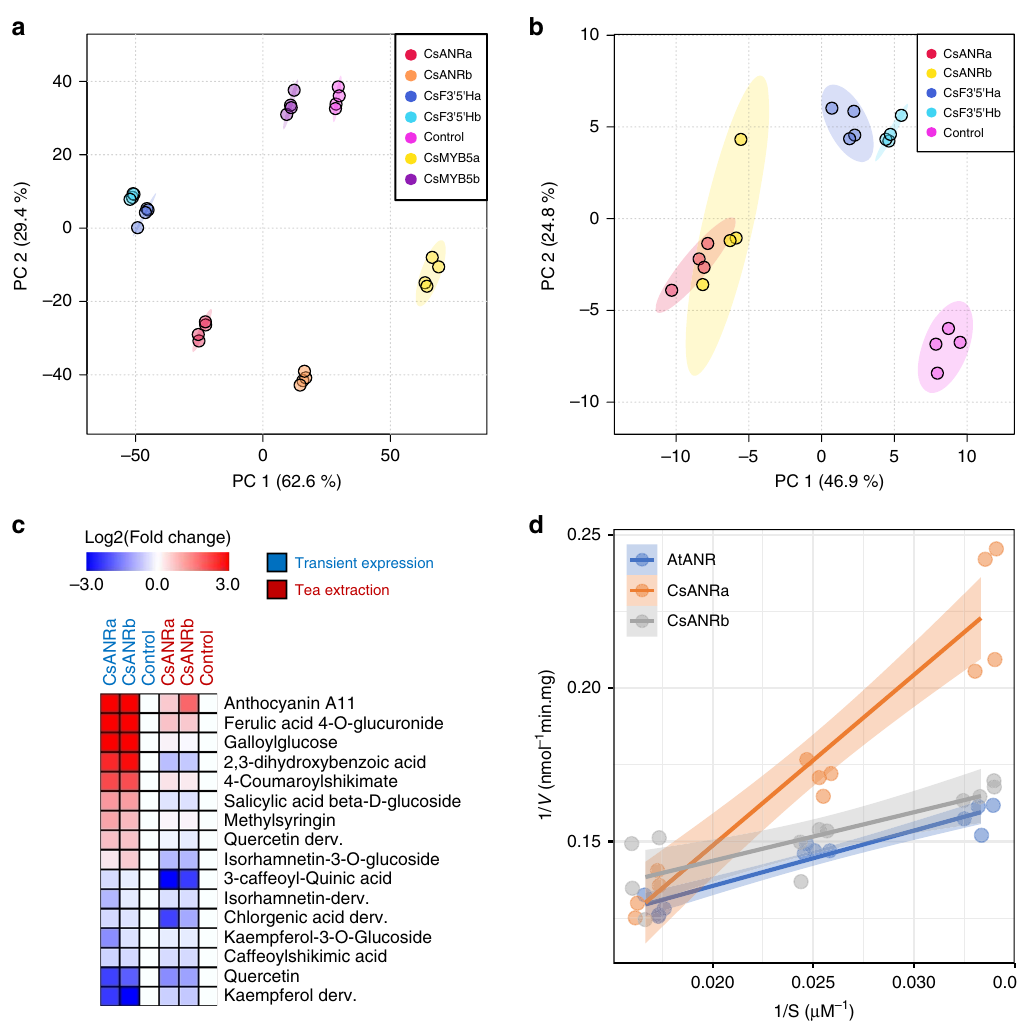
Fig. 5 Functional analysis of three candidate genes. Allele of CsANRa : CGT; Allele of CsANRb : GCC; Allele of CsF3 ′ 5 ′ Ha : TGTT; Allele of CsF3 ′ 5 ′ Hb : TCAC; Allele of CsMYB5a : CAA; Allele of CsMYB5b : CTA. a Transient overexpression of these three genes was conducted in tobacco leaves in which secondary metabolites were subsequently detected by LC – MS. The metabolite pro fi ling of all the overexpression tobacco lines is different from that of the GFP control. The metabolite pro fi ling of the two alleles of each gene is distinct from each other. b The puri fi ed enzymes were incubated with tea extracts revealing their catalytic function in tea secondary metabolism. The dots with the same color in ( a ) and ( b ) indicate the four biological replicates for metabolite pro fi ling. c Heatmap of signi fi cantly changed metabolites in both tobacco leaves (left) and tea extract (right) with presence of CsANR ( P < 0.05; t test; two sided). The free GFP was used as negative control. d Enzyme activity of the anthocyanidin reductase (ANR). The Arabidopsis ANR ( AtANR ) was used as assay control. Four measurements were conducted for each enzyme under each concentration of cyanidin chloride. Data points are jittered to improve legibility. Shadows indicate the 95% con fi dence interval of linear regression. Two independent experiments were performed and generated similar results. Source data underlying a , b , d are provided as a Source Data fi